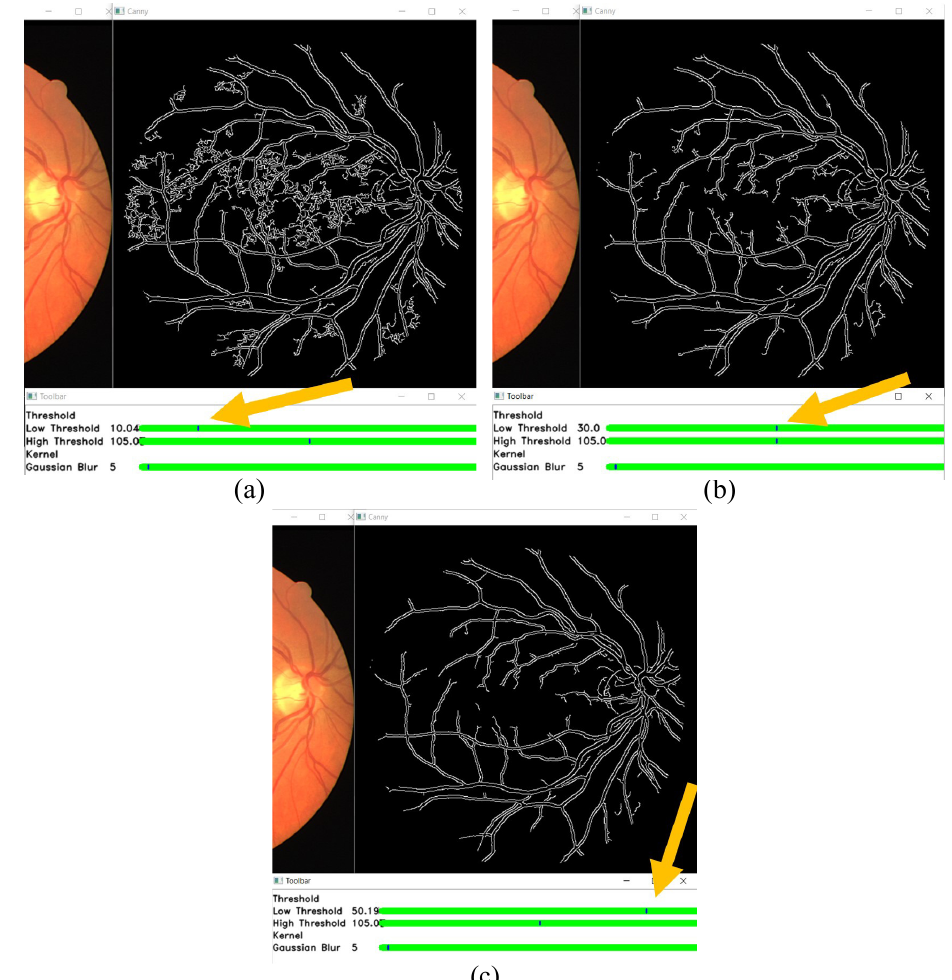
Figure 10. High threshold at 105, and low threshold at ( a ) 10 (the obtained PFOM value is 0.5886), ( b ) 30 (the obtained PFOM value is 0.600), and ( c ) 50 (the obtained PFOM value is 0.5511). Figure 12 shows the effect of changing the size of the kernel in the GUI toolbar. The yellow arrows in this figure show the location of the changes of the settings that are done on the trackbar. A visual comparison of the effects of Gaussian kernel size 3, 5, 7, and